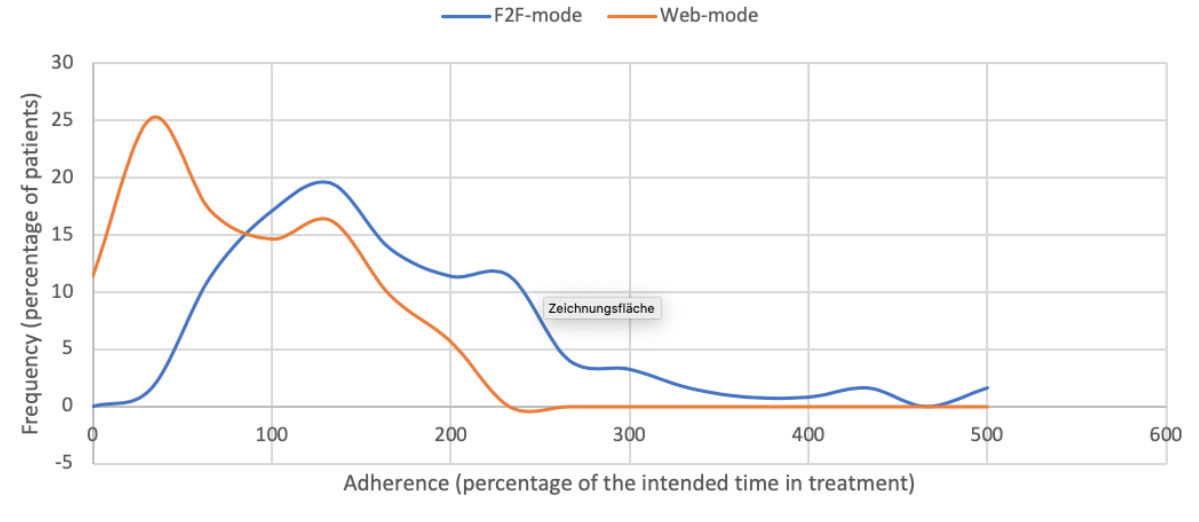
Figure 3. Adherence within the blended smoking cessation treatment group to the two modes of the treatment: face-to-face (F2F) mode vs web